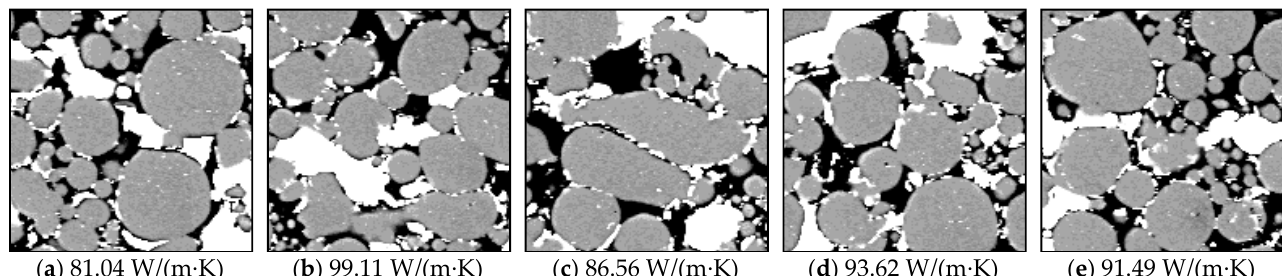
Figure 7. Regions of Figure 4 with about 12% porosity and 20% of Sn in volume and their average λ eff ( Num = 22,201). The side of each micrograph is 80.54 µm in length. ( a – e ) refer to different regions chosen from Figure 4 with their effective thermal conductivity.